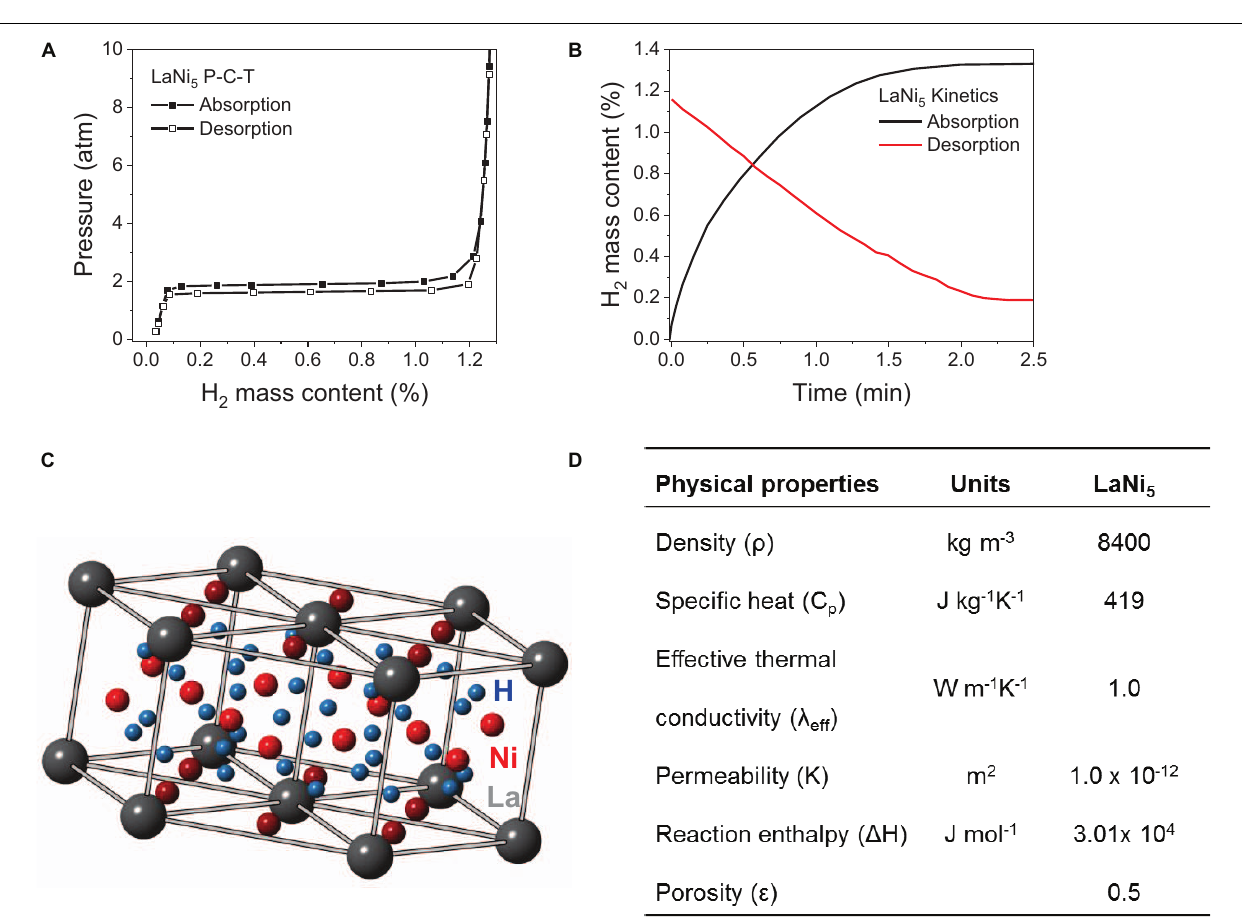
Frontiers in Energy Research |